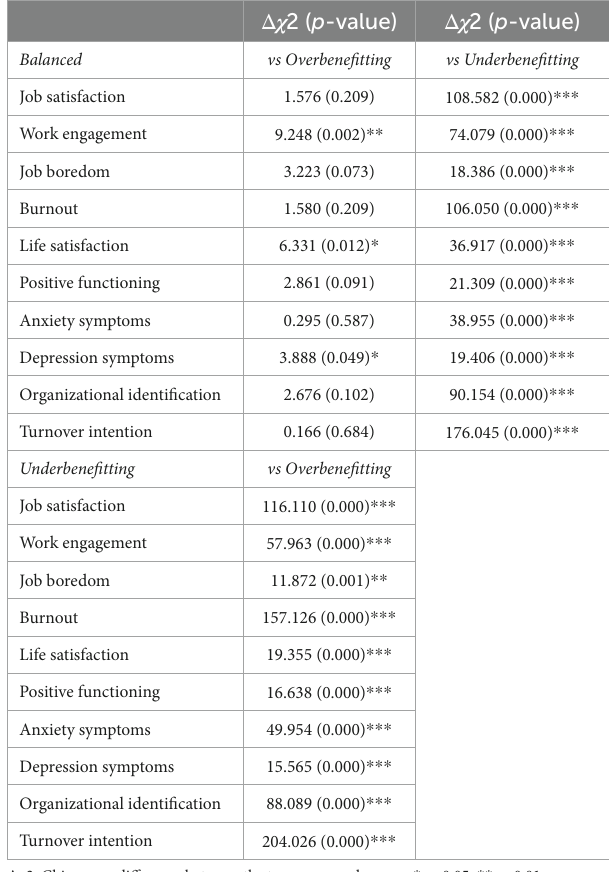
TABLE 4 Equality tests of means across classes using automatic BCH procedure in Mplus with 2 degrees of freedom from the overall test. Δ χ 2 ( p -value) Δ χ 2 ( p -value) Balanced vs Overbenefitting vs